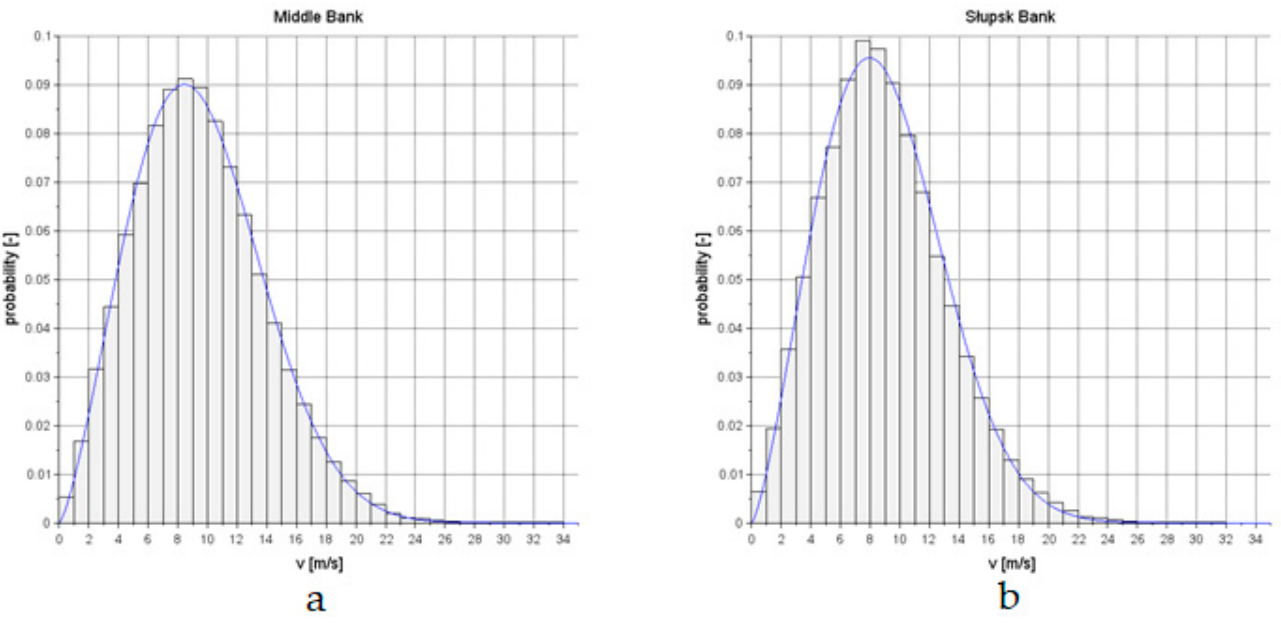
Figure 2. Wind velocity histograms and Weibull distribution at a height of 110 m: ( a ) on Middle Bank; ( b ) on Słupsk Bank.